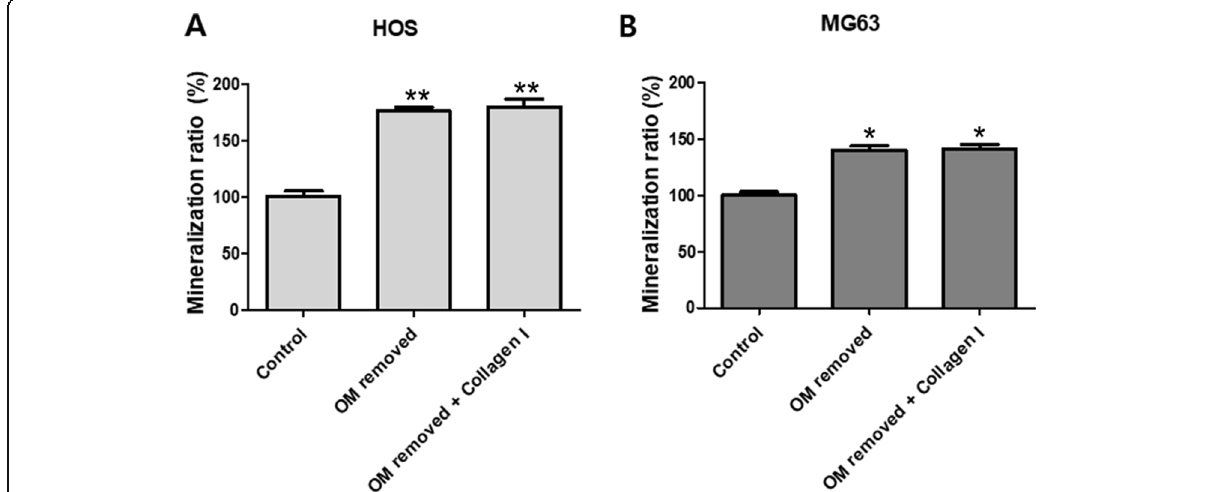
Fig. 6 A graph showing the mineralization ratio of HOS cell secretion ( A ) and MG63 cell secretion ( B ). Each value represents the mean ± S.D. * p < 0.05, ** p < 0.01 compared with